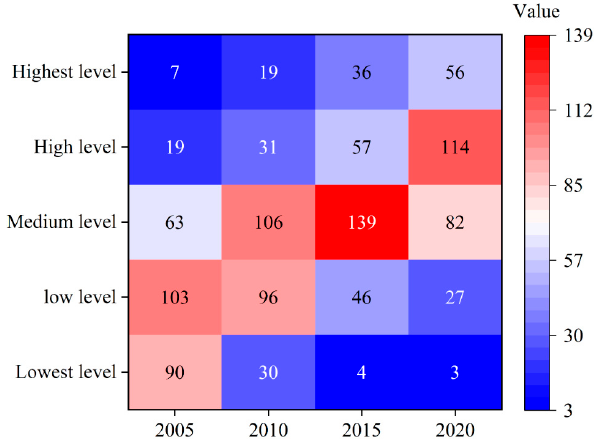
Figure 2. The time-series changes in the number of areas at different levels of GLUEUL from 2005 to 2020.